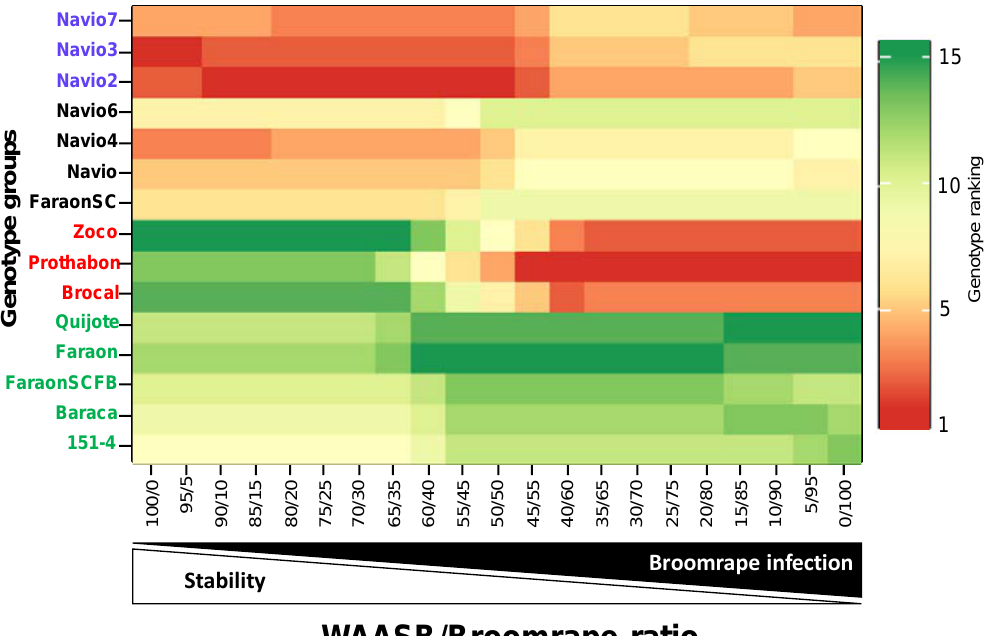
Figure 4. Heatmap showing the rank of 15 faba bean accessions considering different weights for stability and intensity of broomrape infection. Four clusters are shown on the left side of heat map to identify grouping accessions with similar stability and intensity of broomrape infection.